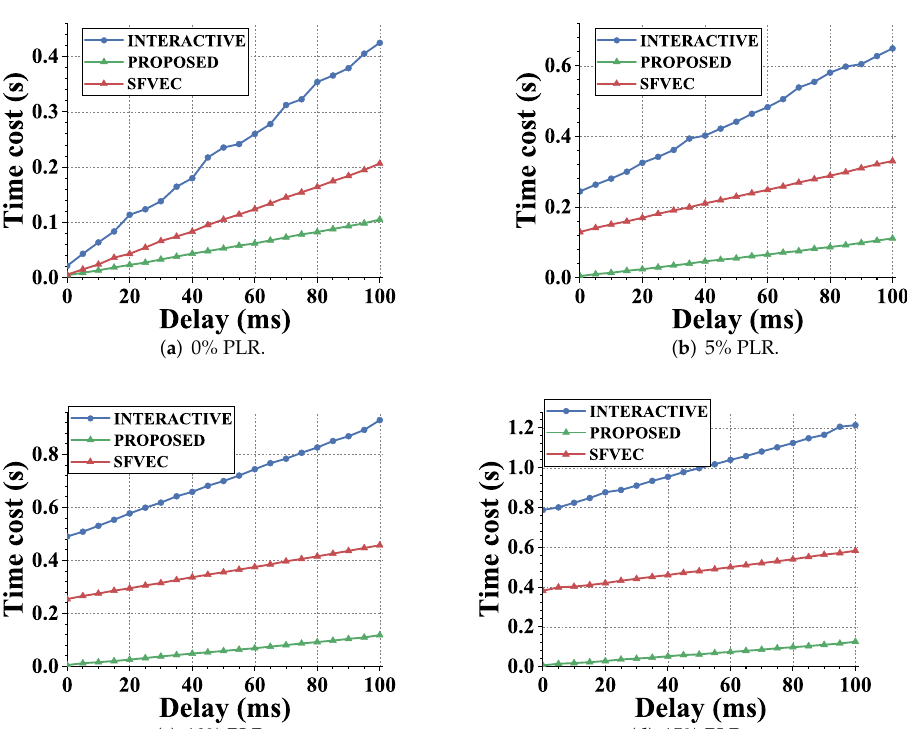
Figure 11. Authentication latency results under different link settings. The abscissa represents different link delay settings, and the subgraph represents different link packet loss rate settings. Authentication latency is defined as the time cost between the GW starting the authentication process and the shared key being negotiated. ( a ) Packet loss rate = 0%, ( b ) packet loss rate = 5%, ( c ) packet loss rate = 10%, and ( d ) packet loss rate =